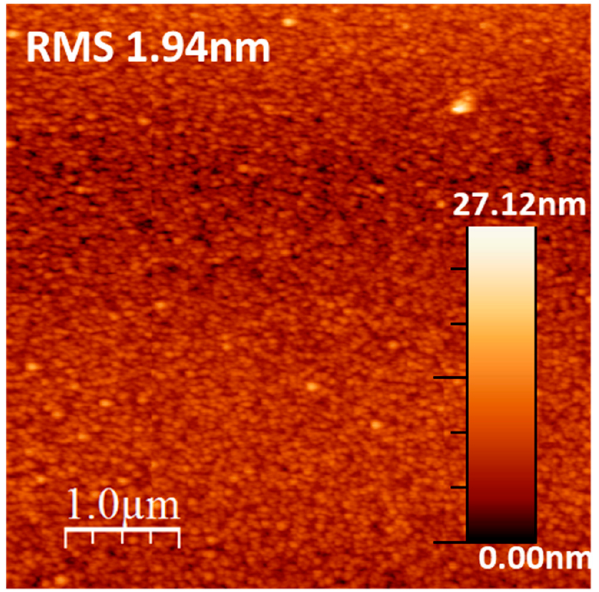
Figure 5. 1 μ m × 1 μ m AFM micrograph of the hydroxyapatite (HA) surface with a RMS roughness coefficient of 1.94 nm.